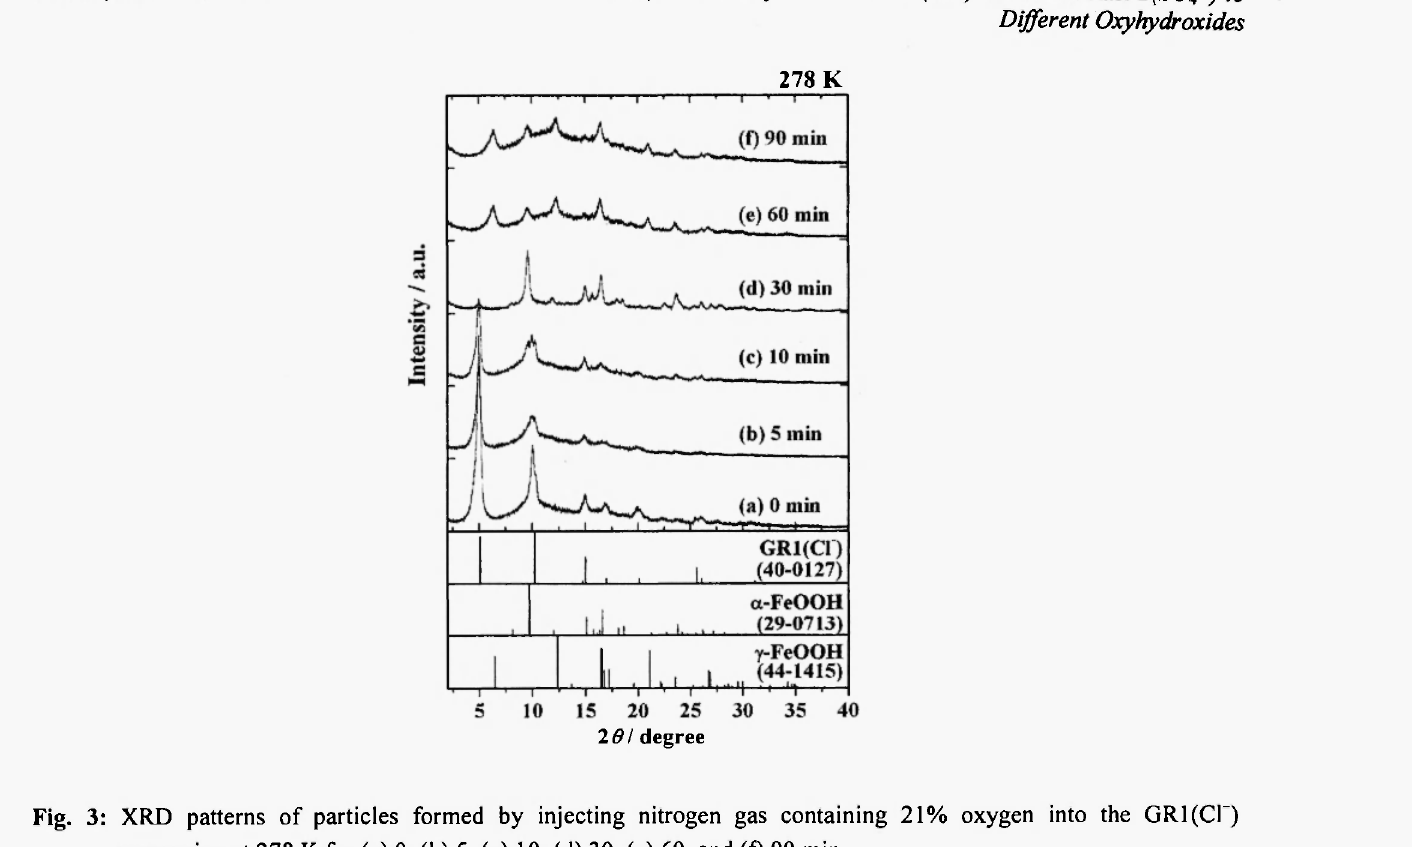
Fig. 3: XRD patterns of particles formed by injecting nitrogen gas containing 21% oxygen into the GR1(CI") suspension at 278 Κ for (a) 0, (b) 5, (c) 10, (d) 30, (e) 60, and (f) 90 min.